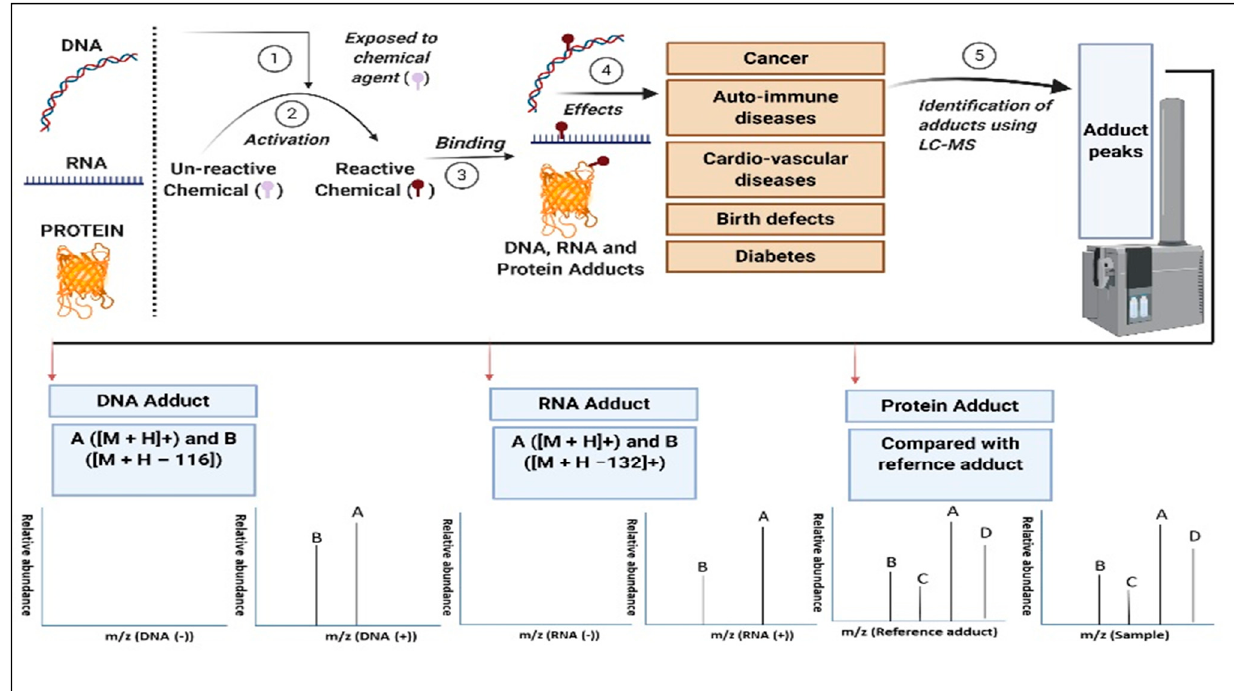
Figure 2. Three types of adducts are formed in biological systems (or organisms) when exposed to chemical agents and their associated health hazards. The adducts (A, B, C, and D) are identified using a fragmentation pattern in the LC-MS spectra. In DNA adducts, the characteristic peaks from the protonation events (M + H) + and cleavage events (M + H − 116) + are detected. In RNA adducts, the characteristic peaks are detected from the protonation (M + H)+ and cleavage events (M + H − 132)+ [20,21]. To identify the protein adducts, we generally compare the spectra data of unknown compounds with the reference adduct. Reference adducts would be synthesized by assuming an electrophile, and they should be compared with the unknown adducts of interest. By adding proposed precursor electrophiles to plasma or whole blood/lysate the reference adducts can be generated, and they are subjected to fragmentation using LC-MS. The synthetic adducts then further will be compared with the novel or unidentified adducts with m/z of the precursor ions, also studying fragmentation patterns and retention times. On the other hand, by using UNIMOD database that lists the protein modifications is also used to identify the adducts[22].